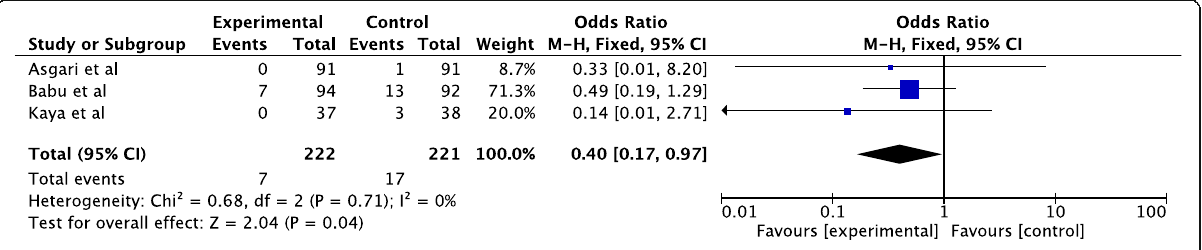
Fig. 5 Forest plot of the rate of glans dehiscence in the included